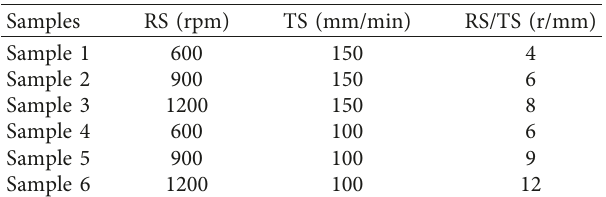
Figure 1: (a) Schematic drawing of the FSW joining process, (b) specific dimensions of the tool, and (c) the locations where tensile, indentation, and EBSD specimens were obtained. Table 2: Investigated welding parameters in experimental scale-up